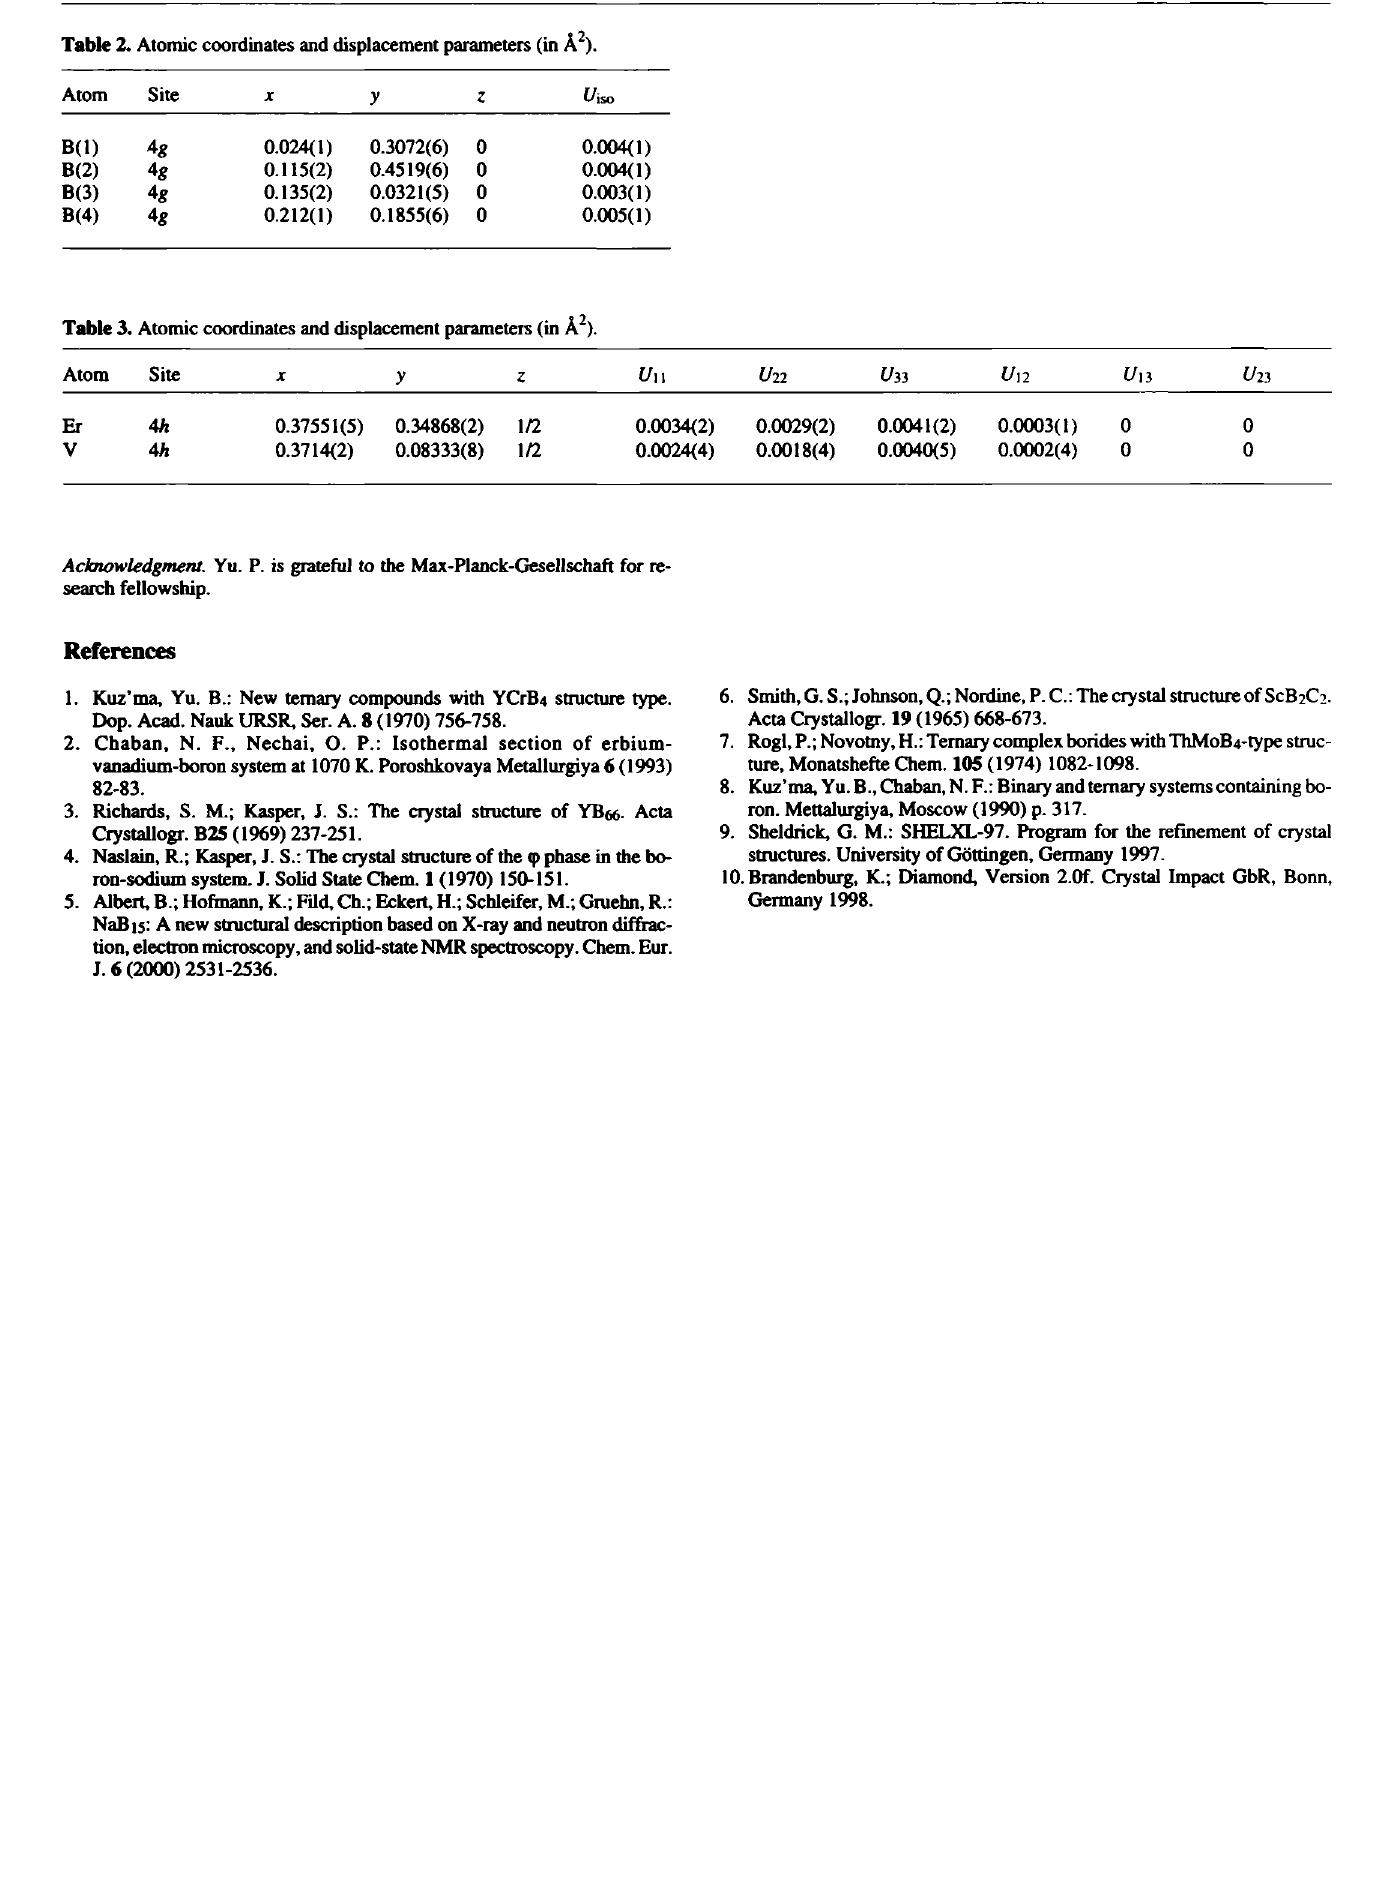
Table 2. Atomic coordinates and displacement parameters (in Â 2 ).